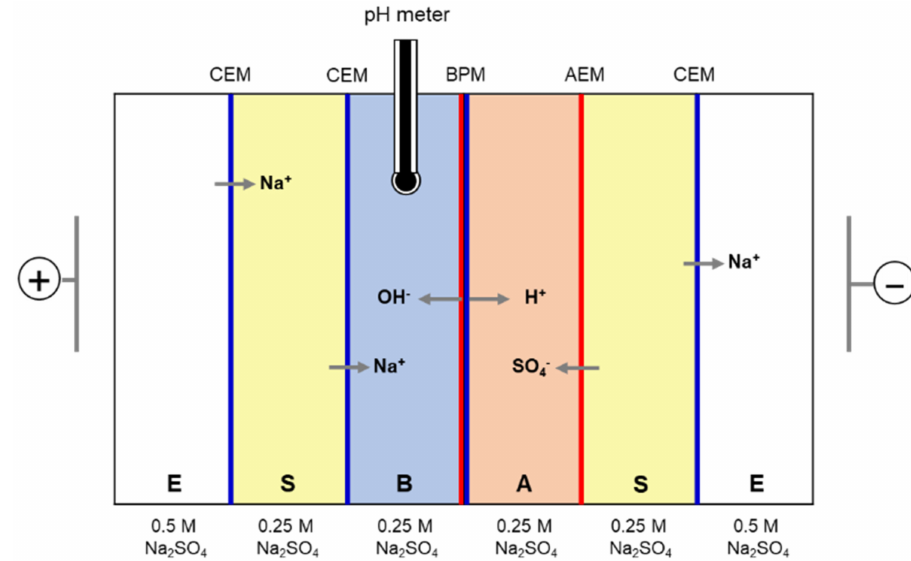
Figure 3. Schematic drawing of 6-compartment WSED cell.